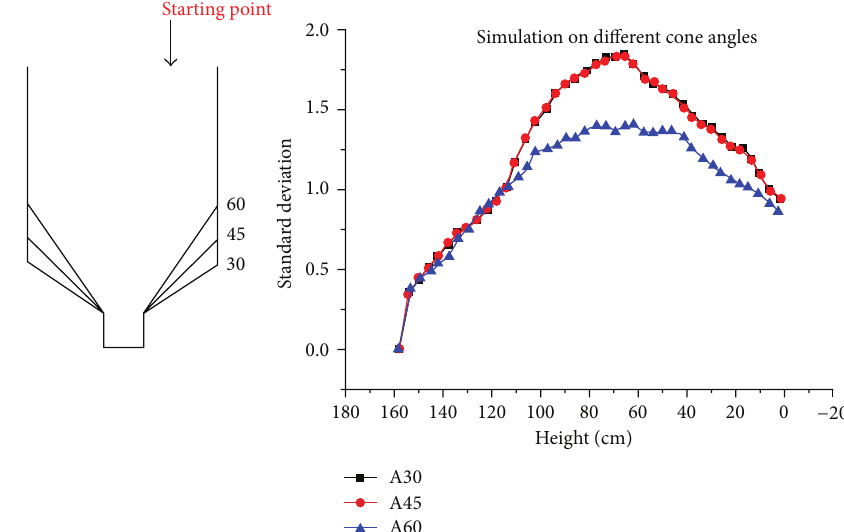
Figure 11: Simulation on different base cone angles.